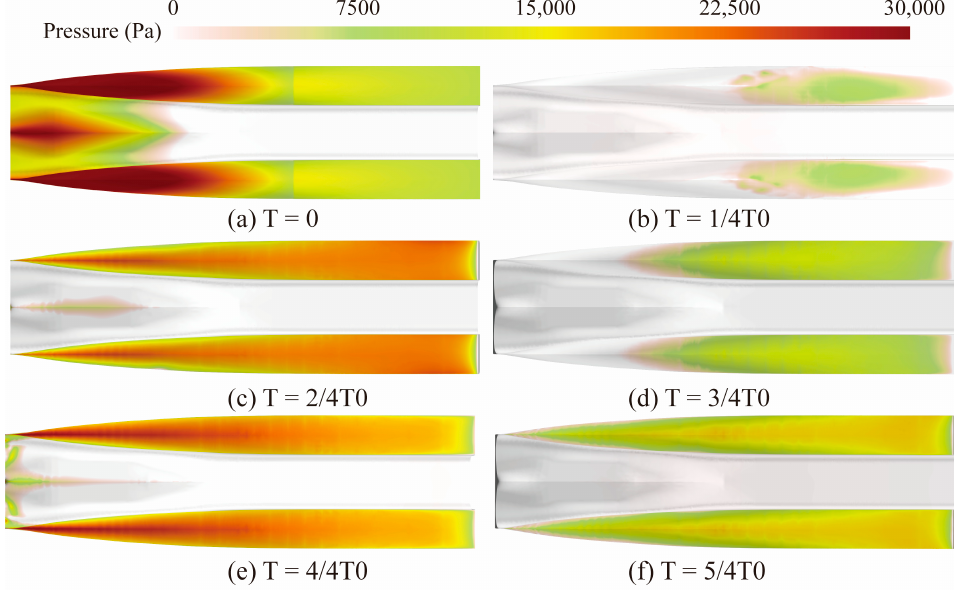
Figure 22. The attitude of USV in waves at typical times under 7 level sea state with the 30° wave direction.